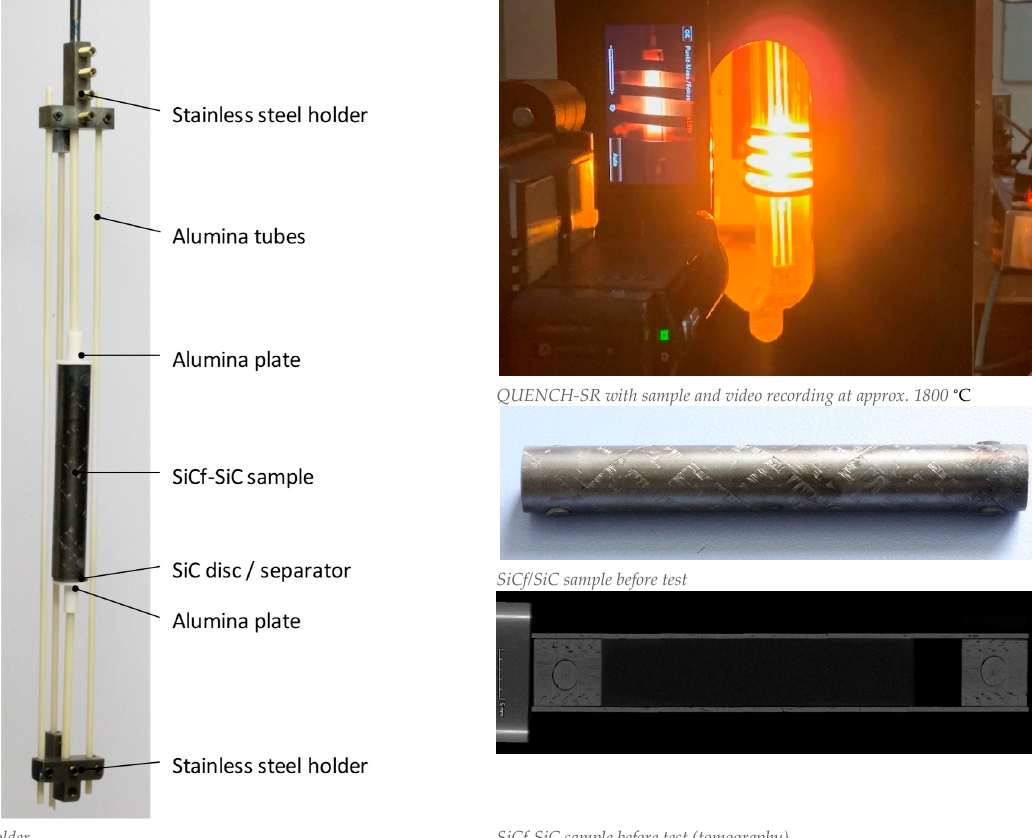
Figure 11. QUENCH-SR facility and SiCf-SiC sample with graphite susceptor. A number of experiments with SiC f -SiC ceramic-matrix composite (CMC) cladding tubes from various manufactures have been conducted already with this facility. Figure 12 provides, as one example, results of a transient test with such a cladding tube segment from 1400 ◦ C to 2000 ◦ C [46], which correspond very well to the results obtained with smaller CVD-SiC samples in the LAHF facility. According to the gas release data (Figure 12b), which are a measure for the oxidation kinetics, a protective silica scale should have